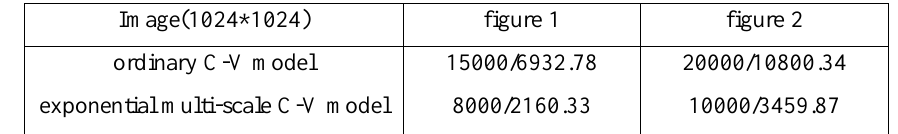
Table.1 The number of iterations/time(s) of ordinary C-V model and exponential multi-scale C-V